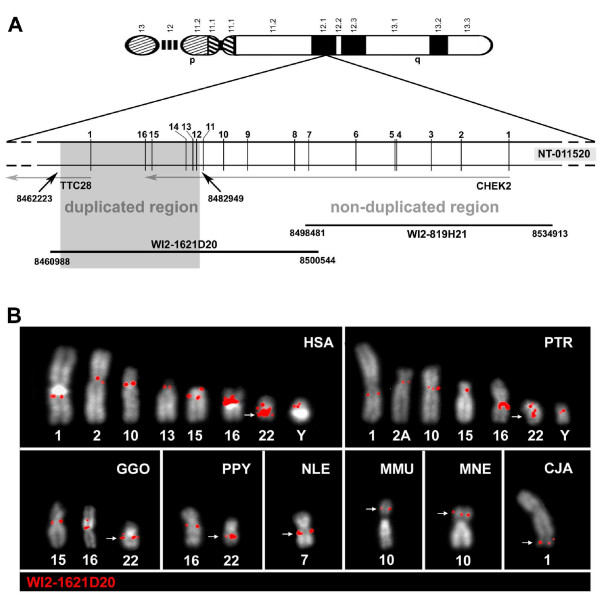
FISH with a CHEK2 fosmid probe from 22q12.1 in anthropoids. (A): Schematic representation of human chromosome 22 with an enlarged view of the analysed CHEK2/TTC28- locus in 22q12.1. All CHEK2 exons and exon 1 of TTC28 are given. Basepair positions for the duplicated region within the chromosome 22 contig NT_011520 are indicated. Localisations of fosmids WI2-1621D20, covering the duplicated region, and WI2-819H21, covering the CHEK2 non-duplicated region are given below. (B) Comparative FISH of fosmid WI2-1621D20 (labelled in red) covering the ancestral duplicated CHEK2 locus in 22q12.1 on human (HSA), chimpanzee (PTR), gorilla (GGO), orangutan (PPY), white-cheeked crested gibbon (NLE), rhesus macaque (MMU), pig-tailed macaque (MNE) and marmoset (CJA) metaphase chromosomes. The great ape chromosomal designations are given according to [65], for NLE according to [67], for MMU, MNE and PHA according to [47] and for CJA according to [66]. White arrows indicate the ancestral CHEK2 locus.